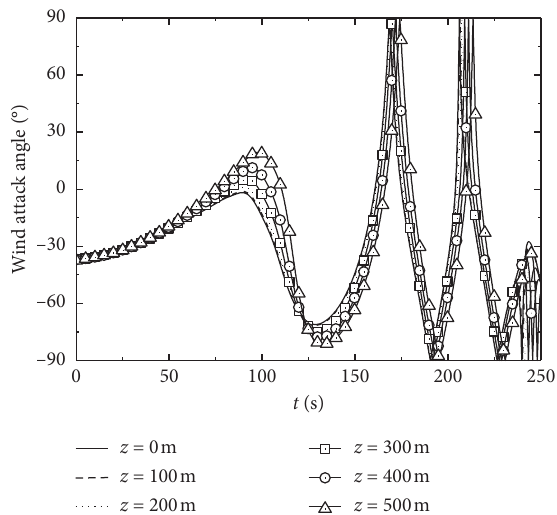
Figure 11: Time-history curves of wind attack angle in the flat terrain.